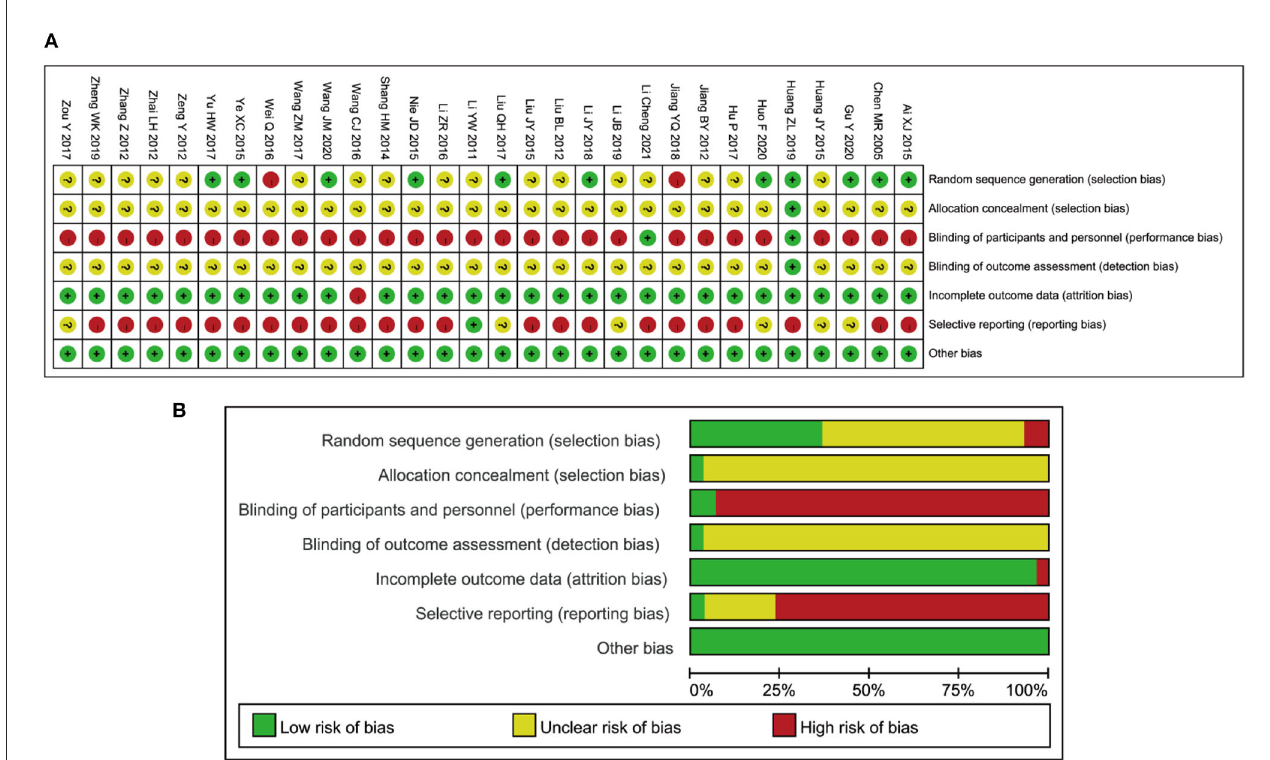
FIGURE2 Risk of bias from included studies. (A) Risk of bias summary. (B) Risk of bias